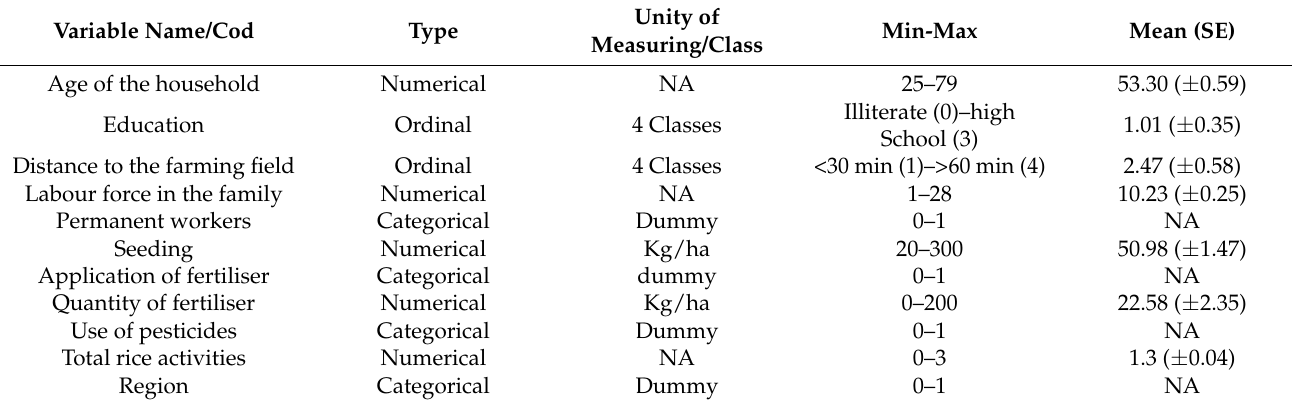
Table 2. Drivers for rice farming systems (RFSs), and predictors of production and productivity of rice, in the Ch ó kw è Irrigation